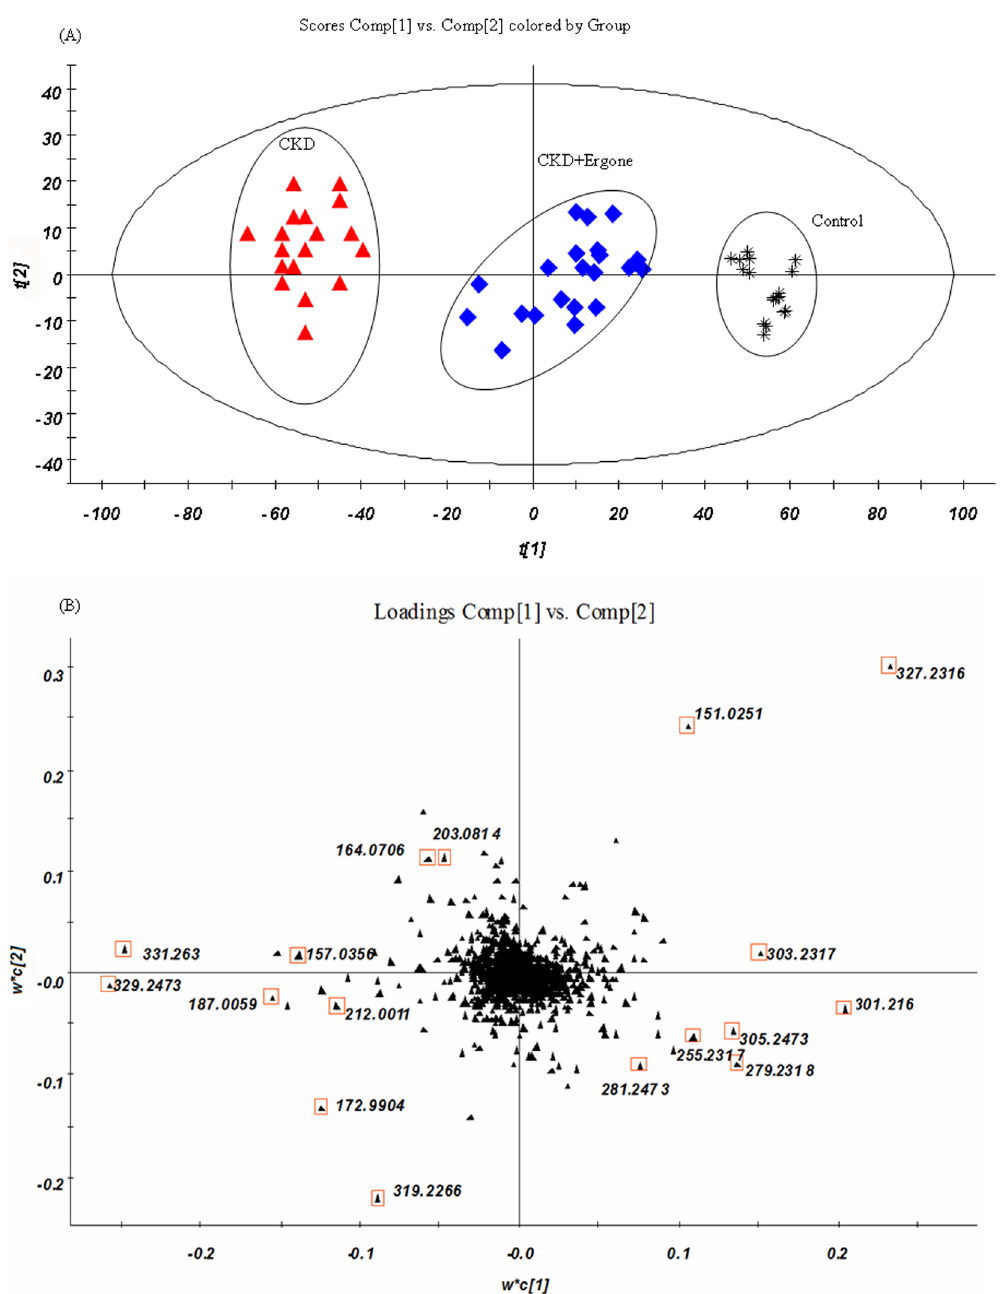
Fig. 3. Partial least squares discriminant analysis of in the three different groups. PLS-DA scores plot (A) loading plot (B) of kidney tissue from (*) control, ( m ) CKD and ( ¤ ) CKD + Ergone groups. The variables marked ( % ) are the metabolites selected as potential biomarkers.